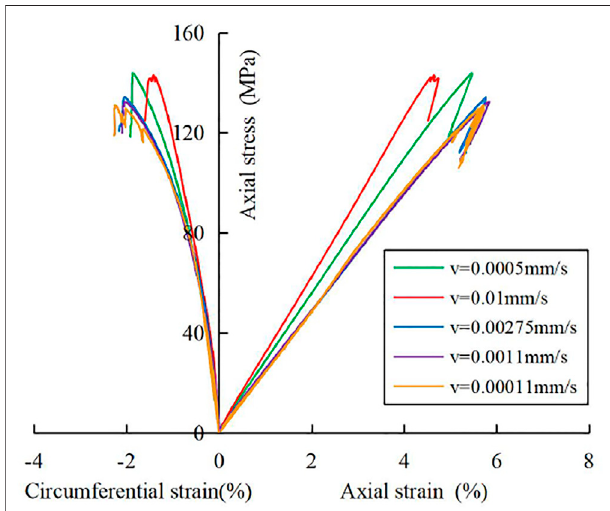
FIGURE 6 | Stress – strain curves at different loading